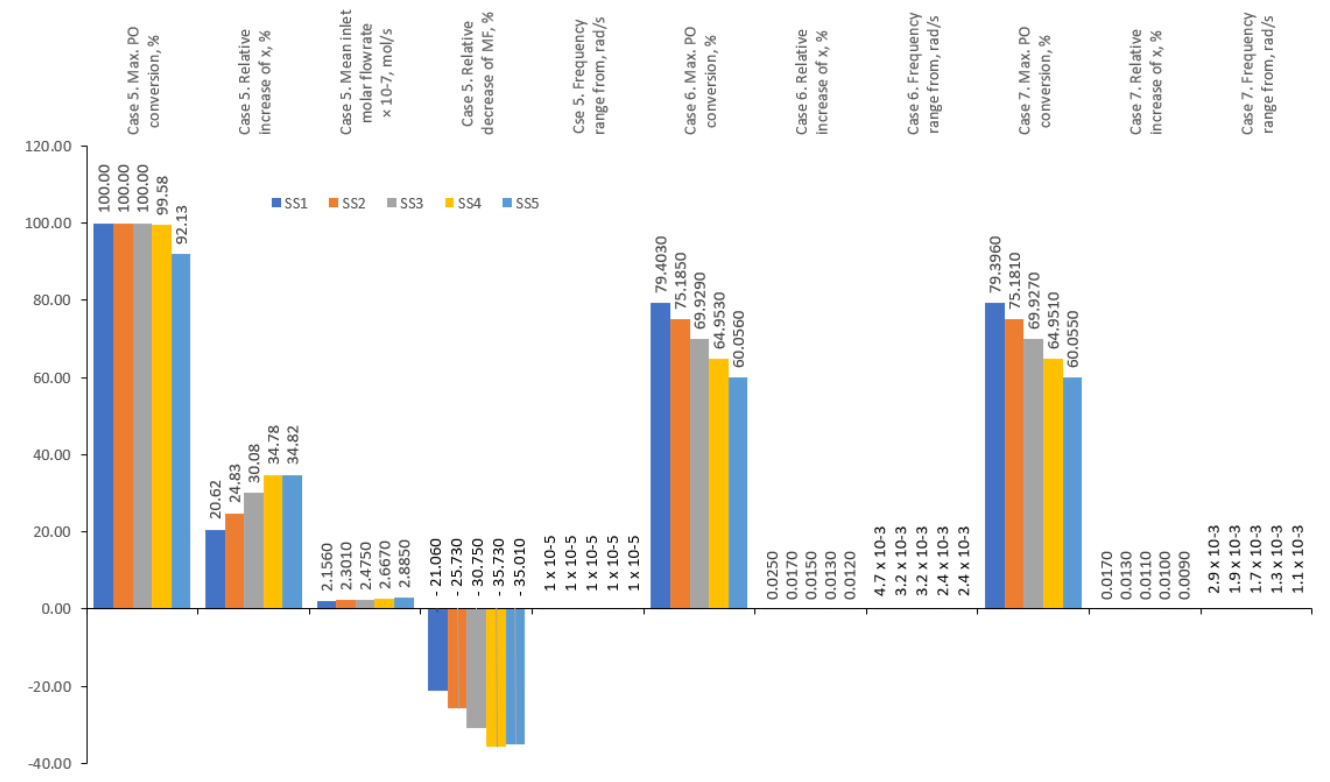
Figure 5. An overview of the possible improvement during simultaneous modulations of two input parameters for Case 5 (modulation of flowrate and acid molar fraction), Case 6 (temperature and acid molar fraction) and Case 7 (temperature and flowrate).